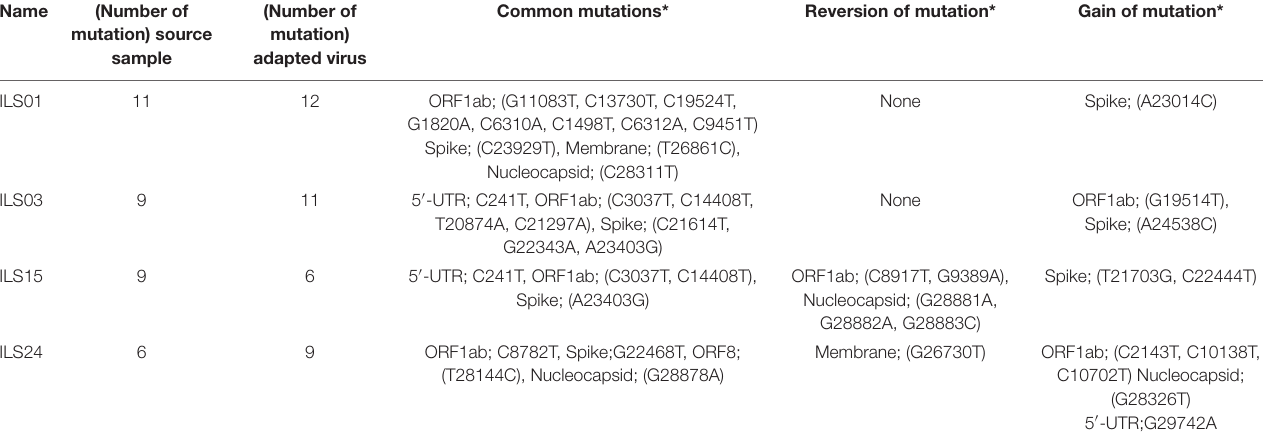
TABLE 4 | Tabular representation of SARS-CoV-2 gene-specific non-synonymous mutations in both the swab samples and cell culture adapted strains.